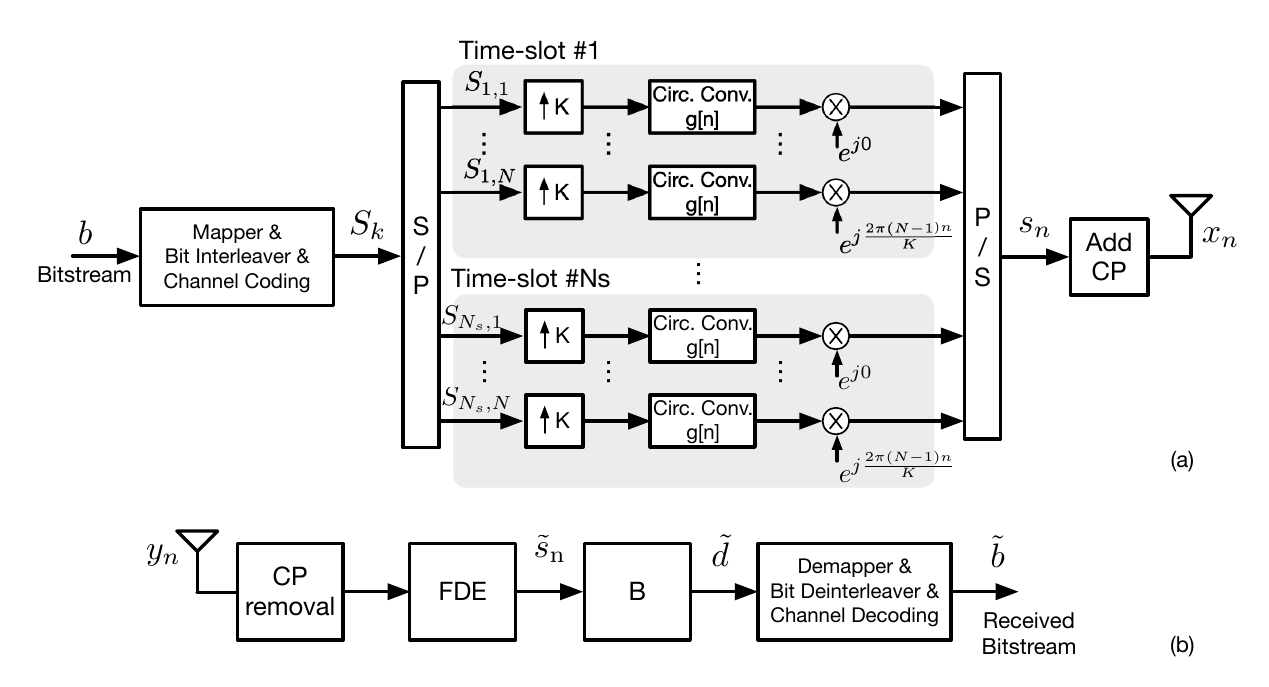
Figure 3. GFDM transmitter ( a ) and receiver ( b